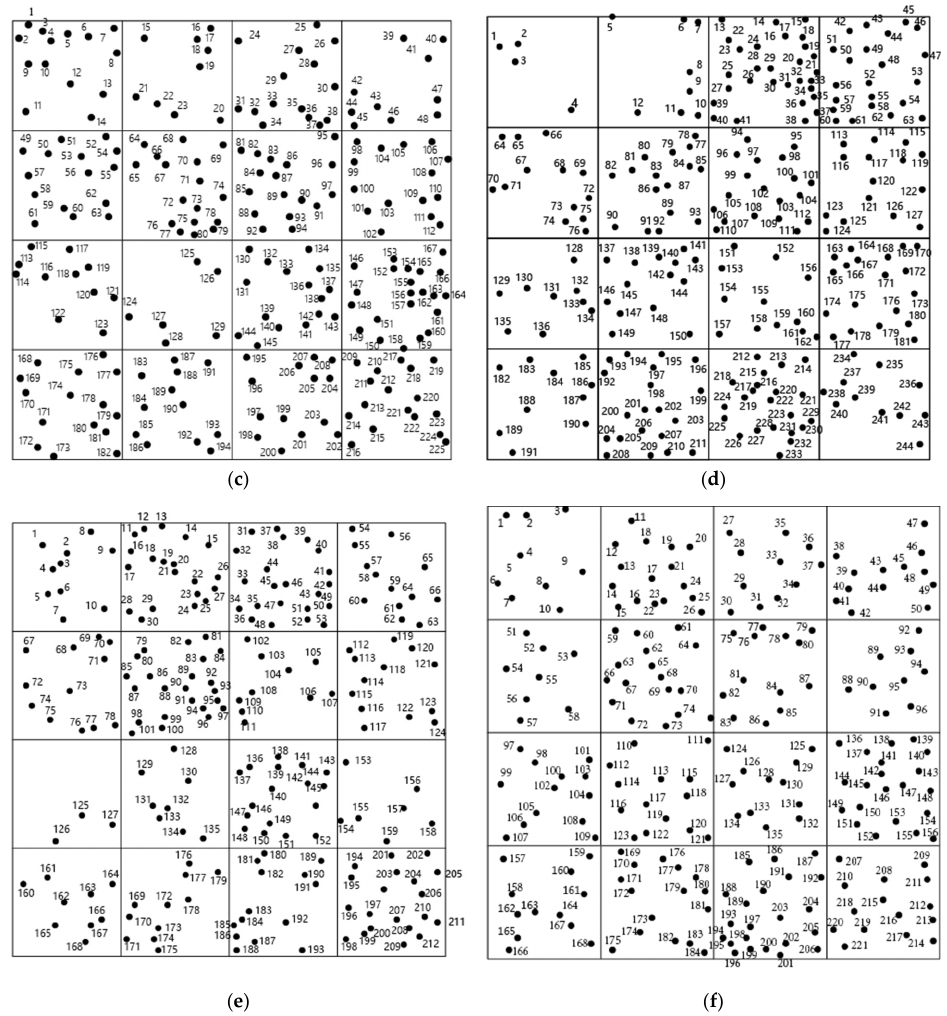
Figure 22. Distribution diagram of 40 mm × 40 mm flexural cross-section steel fibers. ( a ) GT00 Left section (The number of fibers is 213); ( b ) GT00 Right section (The number of fibers is 202); ( c ) GT10 Left section (The number of fibers is 225); ( d ) GT10 Right section (The number of fibers is 244); ( e ) GT20 Left section (The number of fibers is 212); ( f ) GT20 Right section (The number of fibers is 221). The respective section was divided into 16 regions, and an in-depth analysis was conducted to generate Figure 23. The red circle represents less than 10 steel fibers and the green circle represents more than 10 steel fibers. According to Figure 23a,b, there were eight areas with fiber number less than 10, three areas with fiber number greater than 20 and 21 areas with fiber numbers between 10 and 20 in the 32 areas in the GT00 cross- section. There were five areas where the number of fibers was less than 10, five areas where the number of fibers exceeded 20 and 20 areas where the number of fibers ranged from 10 to 20 in the 32 areas in the GT10 cross-section. There were six areas where the number of fibers was less than 10, five areas where the number of fibers exceeded 20 and